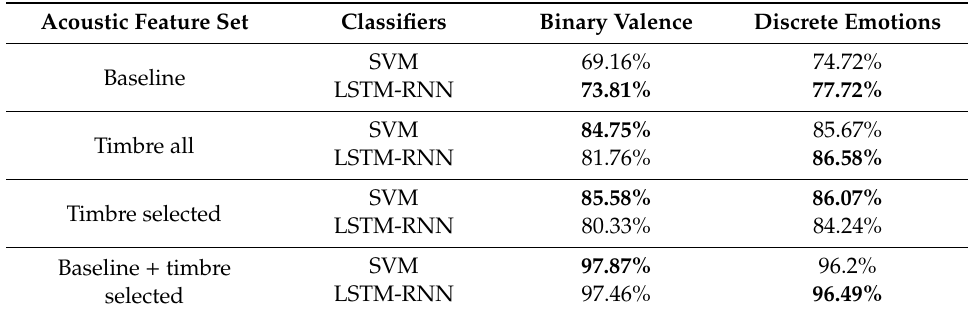
Table 4. Average accuracy rate for all experiments for EMO-DB. (The bold numbers indicate the highest accuracy rate).